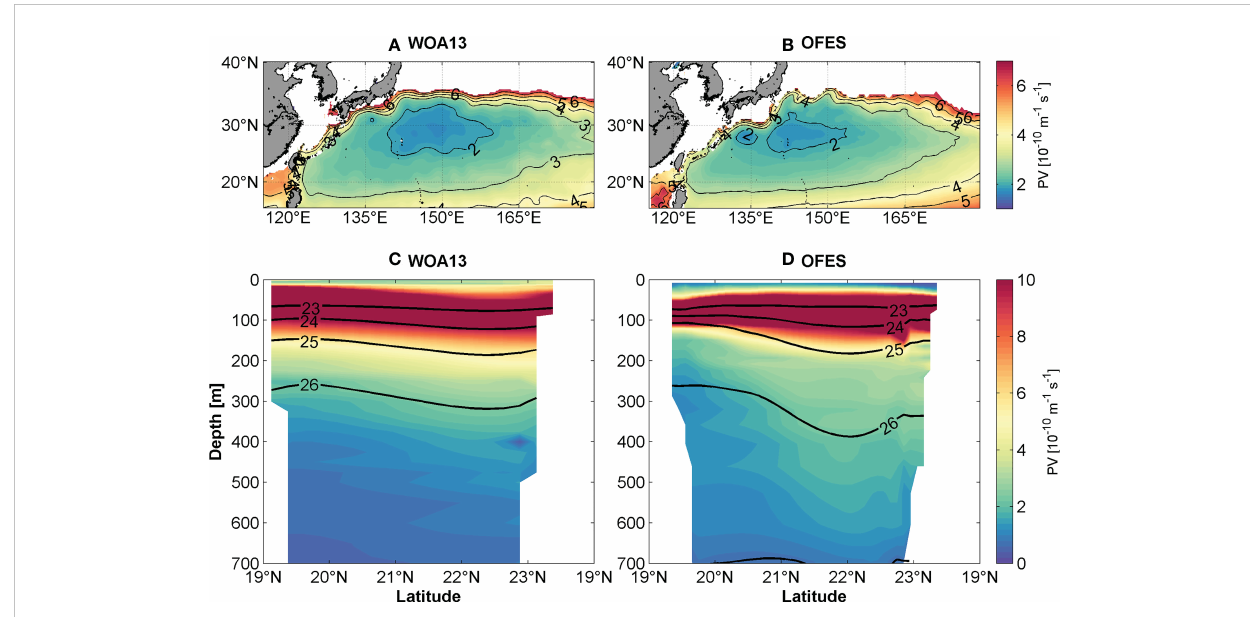
FIGURE 2 Climatology of the PV on the STMW core layer calculated with (A) WOA13 and (B) OFES data and along the 120.5°E section calculated with (C) WOA13 and (D) OFES data (contour: climatology of potential density with 1 kg m -3